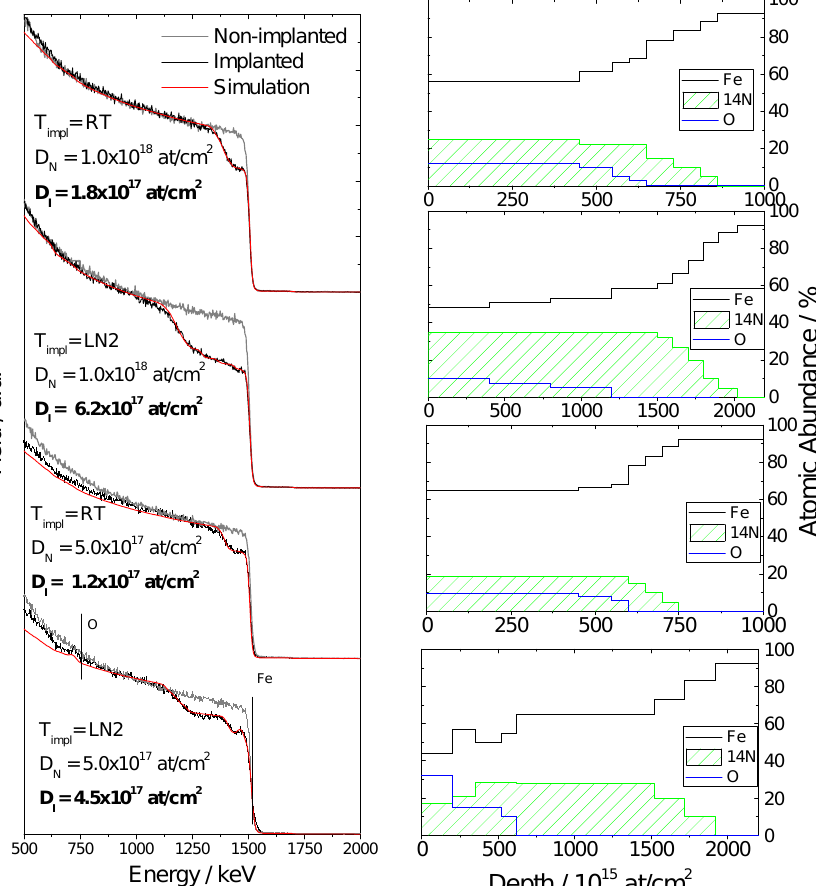
Figure 1. The 2.0 MeV 4 He + Rutherford backscattering spectra (experimental and simulated) of dies steel samples before and after 14 N implantations, and corresponding depth profiles of 14 N, O and Fe extracted from the simulation of the